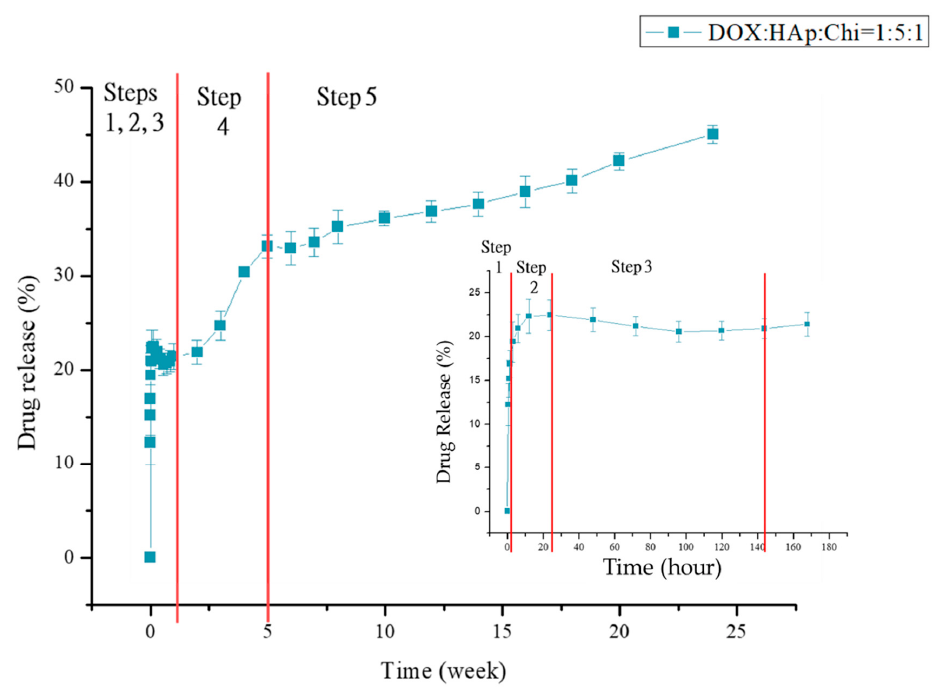
Figure 8. Drug-release profiles of DL5 for 24 weeks present five steps and the right inserted profile is the enlargement of the initial three steps.